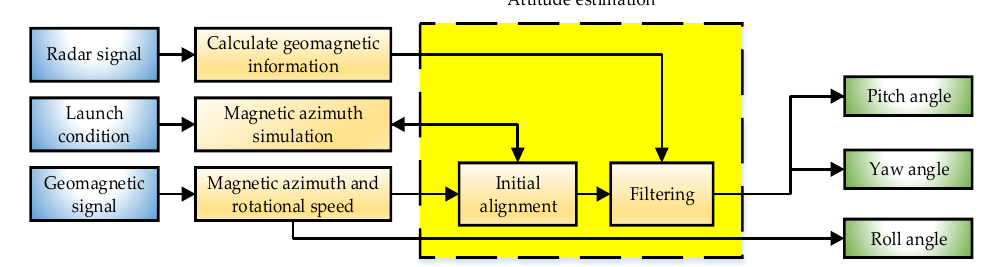
Figure 5. diagram of attitude estimation.